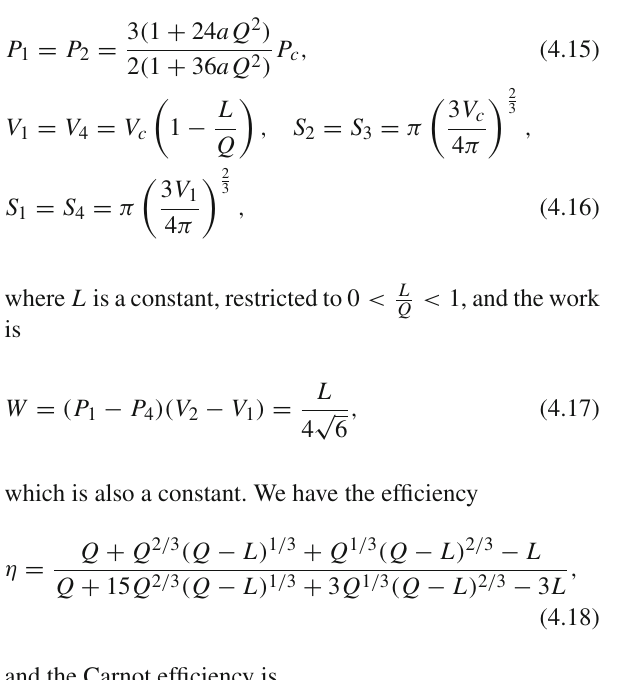
as the function of Q c